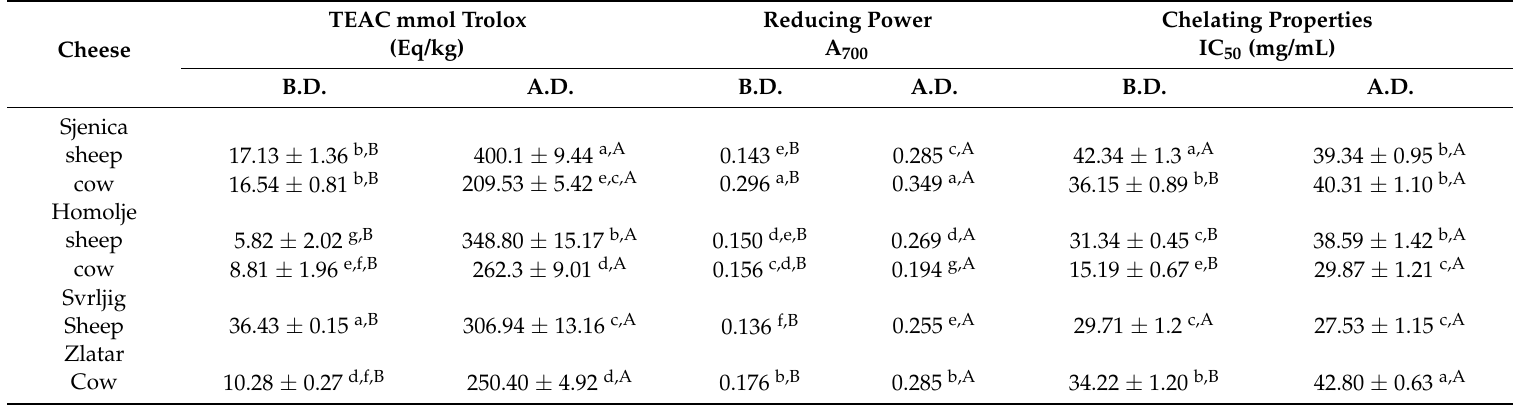
Table 2. The antioxidant properties of traditional white-brined cheeses and their digestates